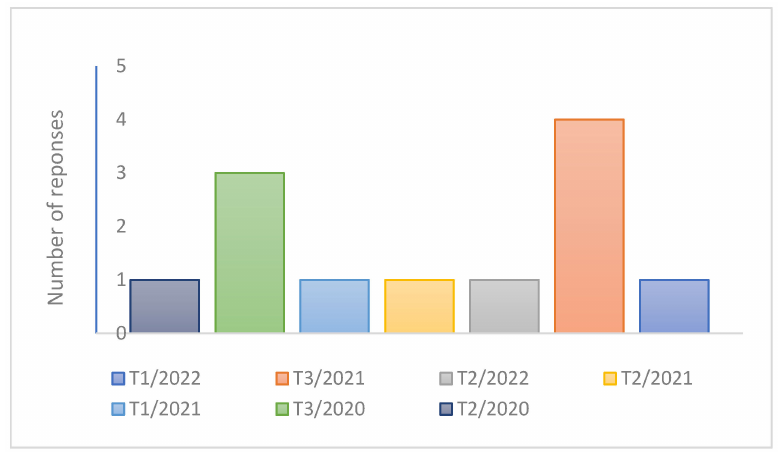
Figure 4. Semester when responses